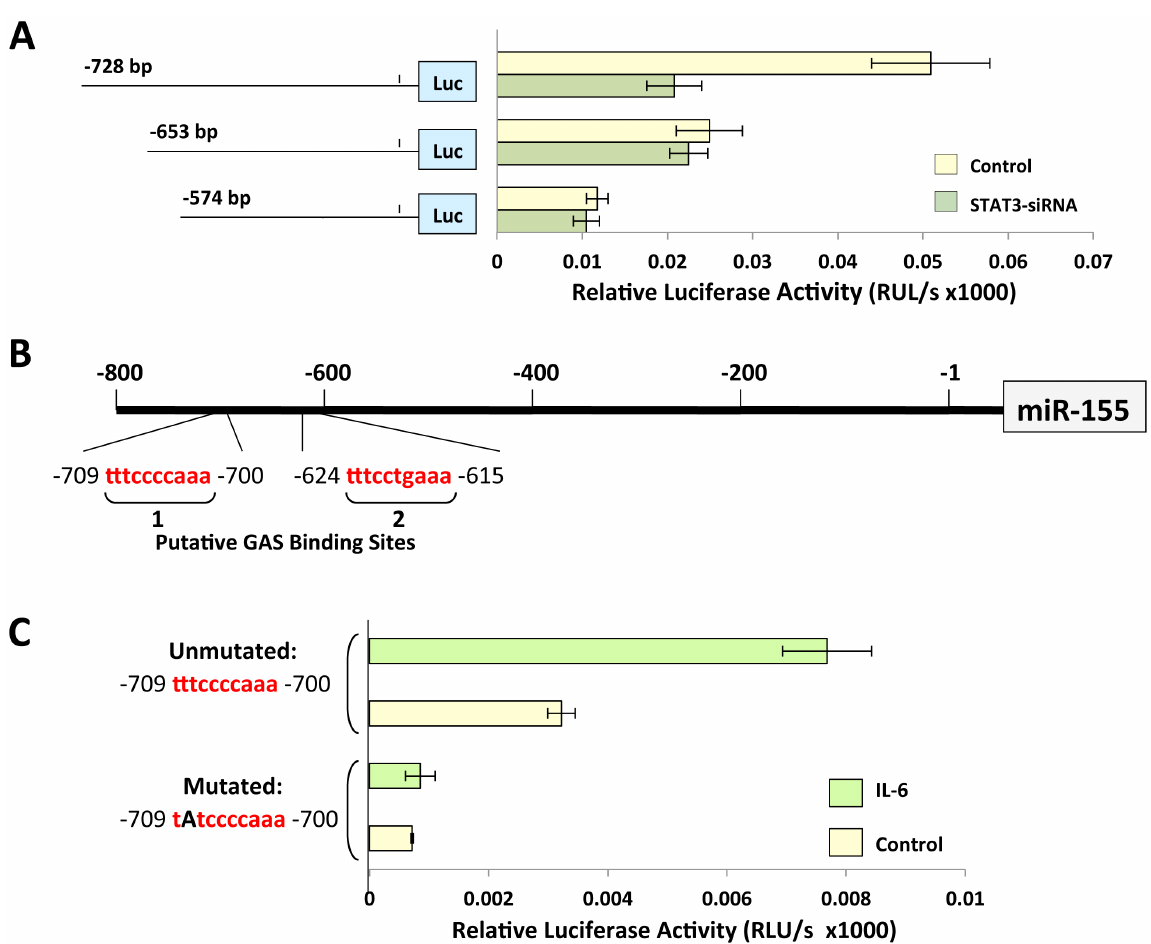
Figure 2. Luciferase activity of MM1 cells transfected with miR-155 promoter fragments. A, MM1 cells were co-transfected with miR-155 promoter fragments and either STAT3-siRNA or scrambled siRNA (control). Luciferase activity was assessed after 48 hours. STAT3-siRNA markedly reduced the luciferase activity of the 2 728 bp fragment but not the shorter 2 653 and 2 574 bp fragments. Means 6 standard deviations of relative luciferase activity units from at least 3 different experiments are shown. B, Schematic diagram of the reporter gene of the human mir-155 promoter. Fragment 2 728 bp contains the putative STAT3 binding sites 1 and 2, fragment 2 635 bp contains the putative STAT3 binding site 2, and fragment 2 574 bp does not contain a STAT3 binding site. C, MM1 cells were transfected with the unmutated or the t-to-a mutated 2 728 bp fragment. Incubation of MM1 cells with 50 ng/ml IL-6 significantly enhanced the luciferase activity of MM1 cells transfected with the unmutated but not with the mutated 2 728 bp fragment. As shown, the luciferase activity of IL-6-stimulated cells transfected with the unmutated 2 728 bp fragment was significantly higher (P , 0.0006) than that of MM1 cells transfected with the mutated fragment. Means 6 standard deviations of relative luciferase activity units from 3 different experiments are